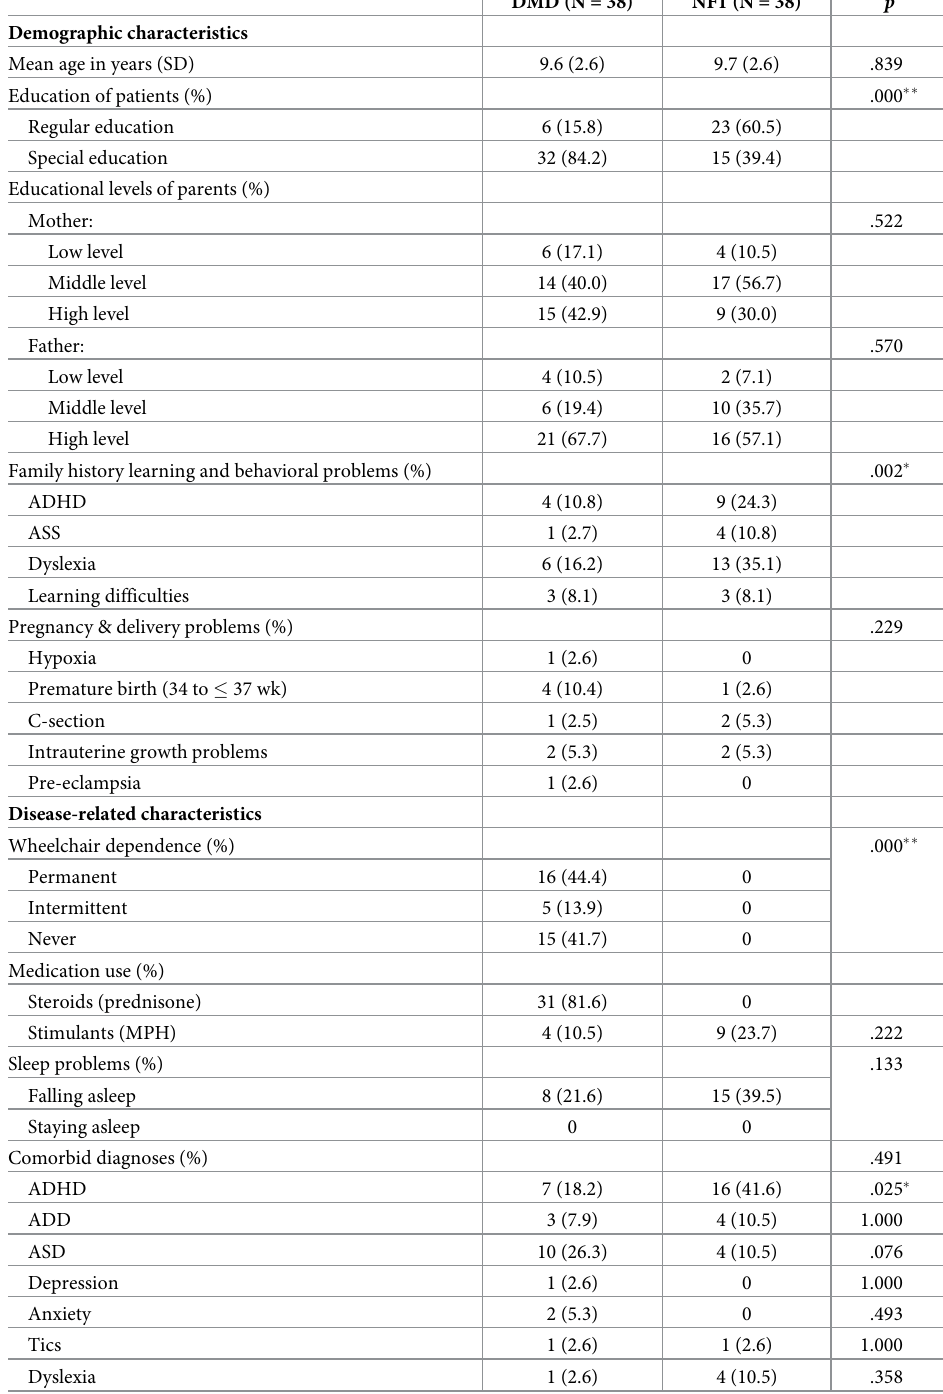
Table 1. Participant